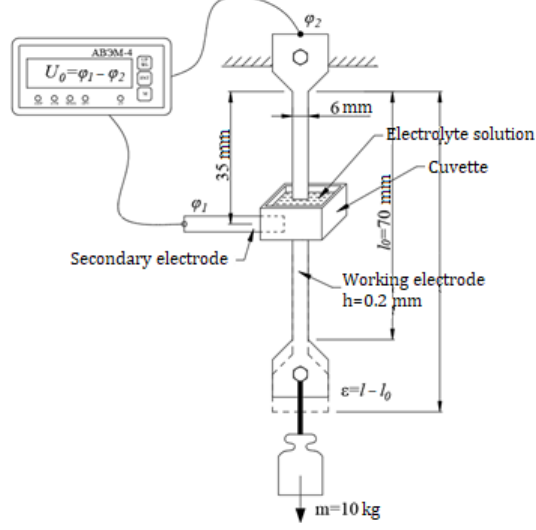
Figure 12. Diagram of a pilot plant.